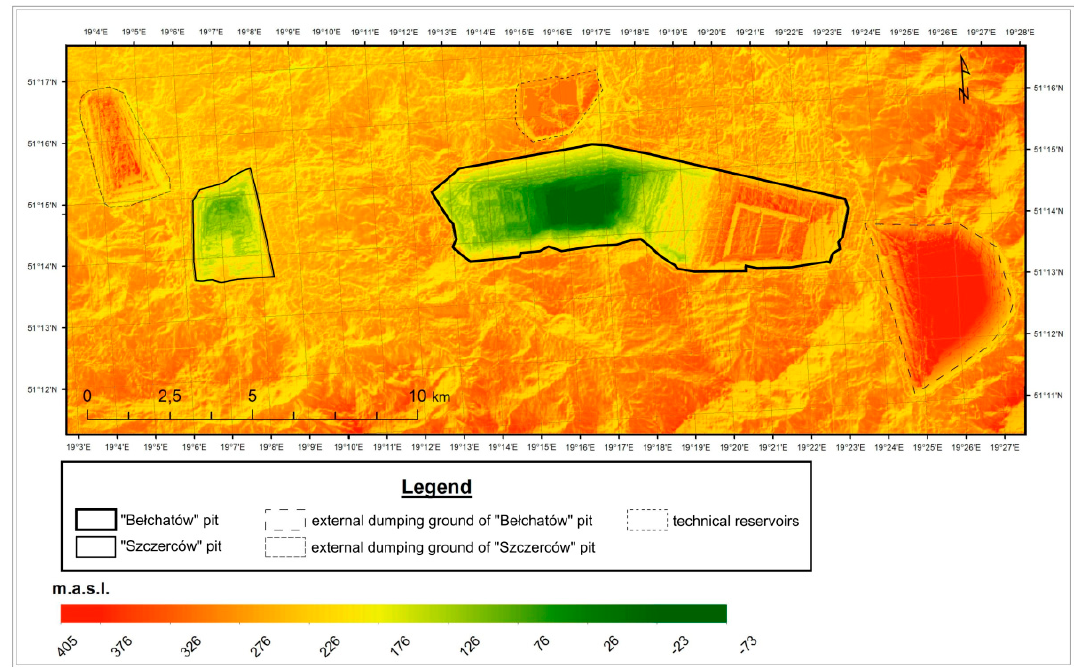
Figure 4. Digital Elevation Model of the analyzed area from the post-investment period—two-dimensional view using a standard color ramp and shaded topography. Source: Own elaboration based on resources from the Department of Geoinformation of the Institute of Urban Geography and Tourism Studies (Faculty of Geographical Sciences, University of Ł ód ź ).